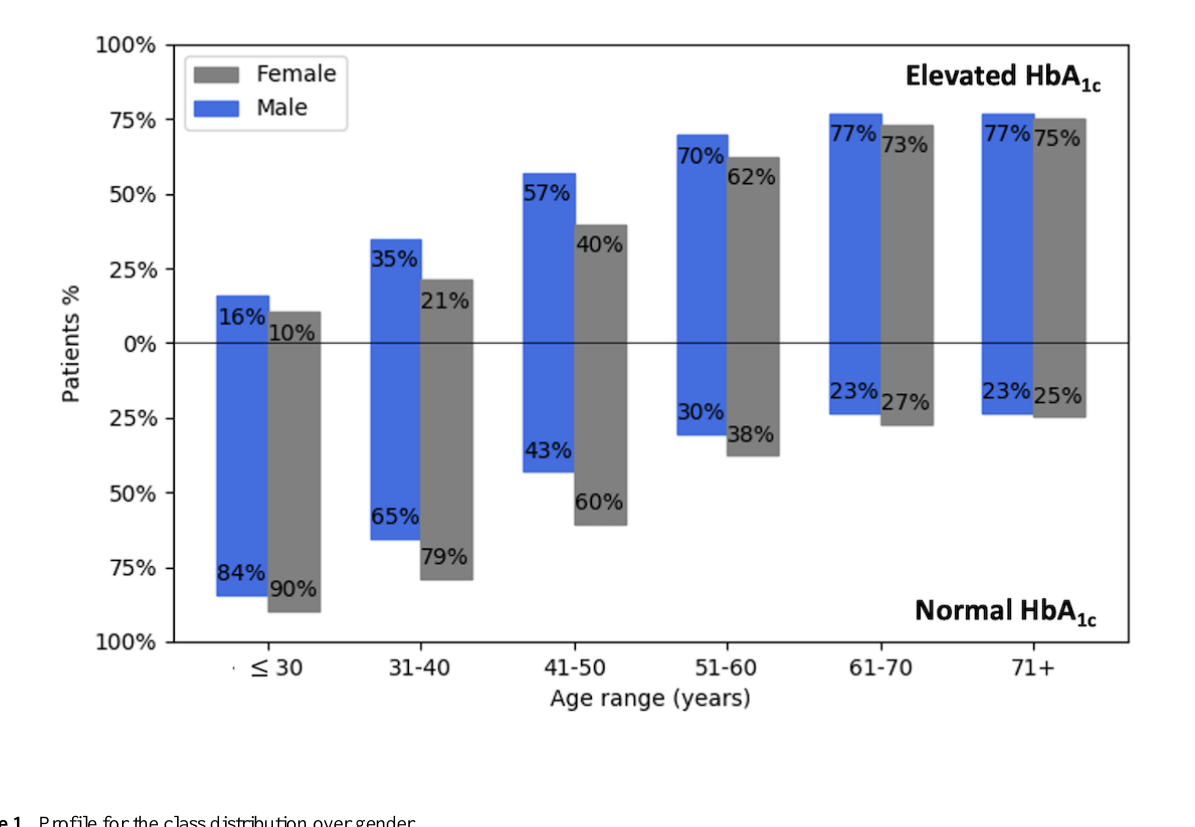
Figure 1. HbA 1c elevation levels distributed over age range and gender in the King Abdullah International Medical Research Center (KAIMRC) data set (before sampling). HbA 1c : glycated hemoglobin.